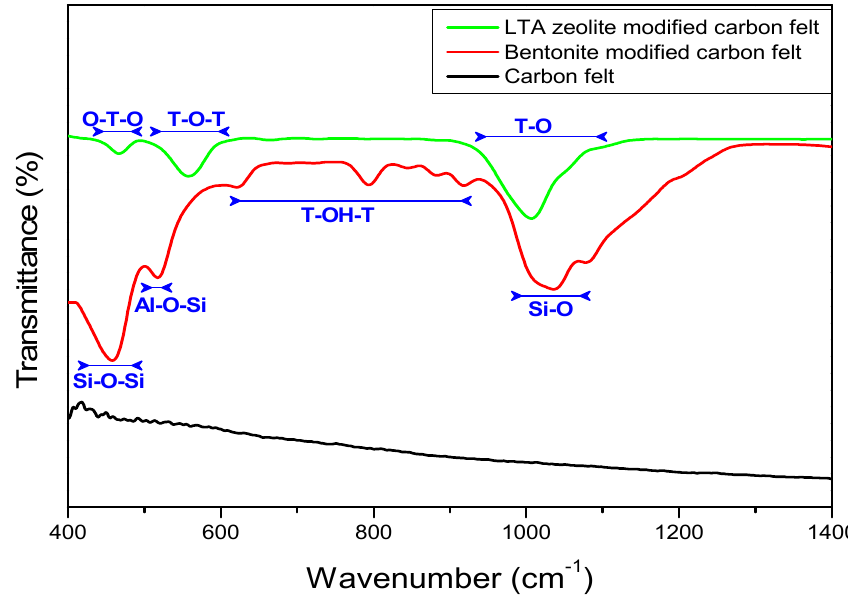
Figure 1. FTIR analysis of modified and unmodified carbon felt.